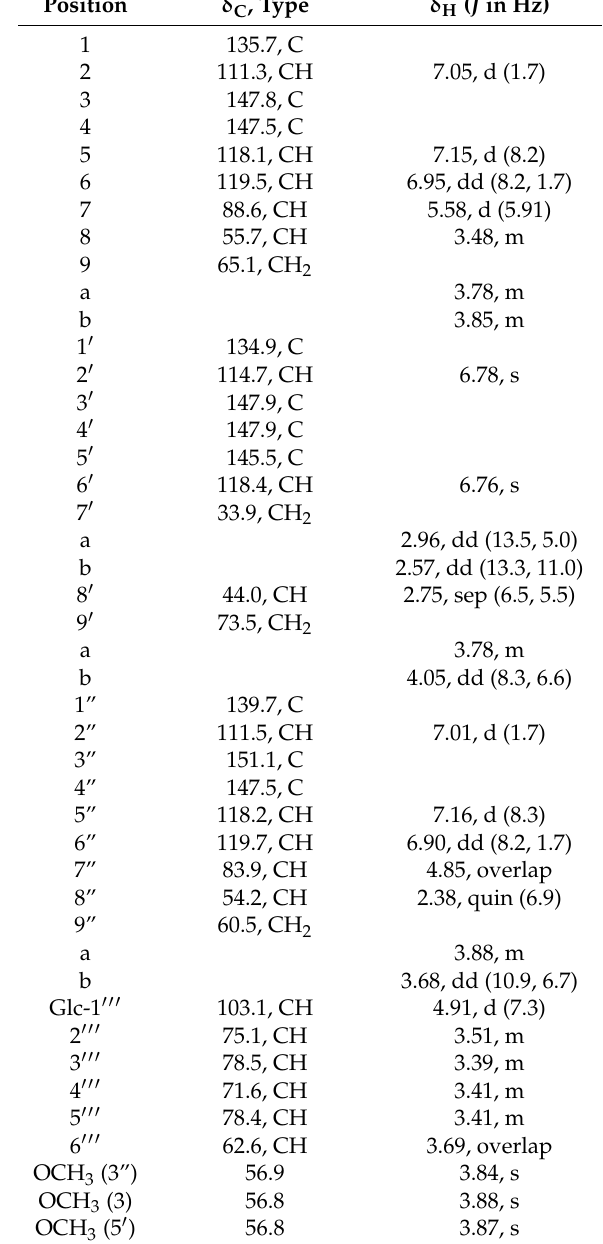
Table 1. 1 H (700 MHz) and 13 C (175 MHz) NMR data of 1 in methanol- d 4 ( δ in ppm) a